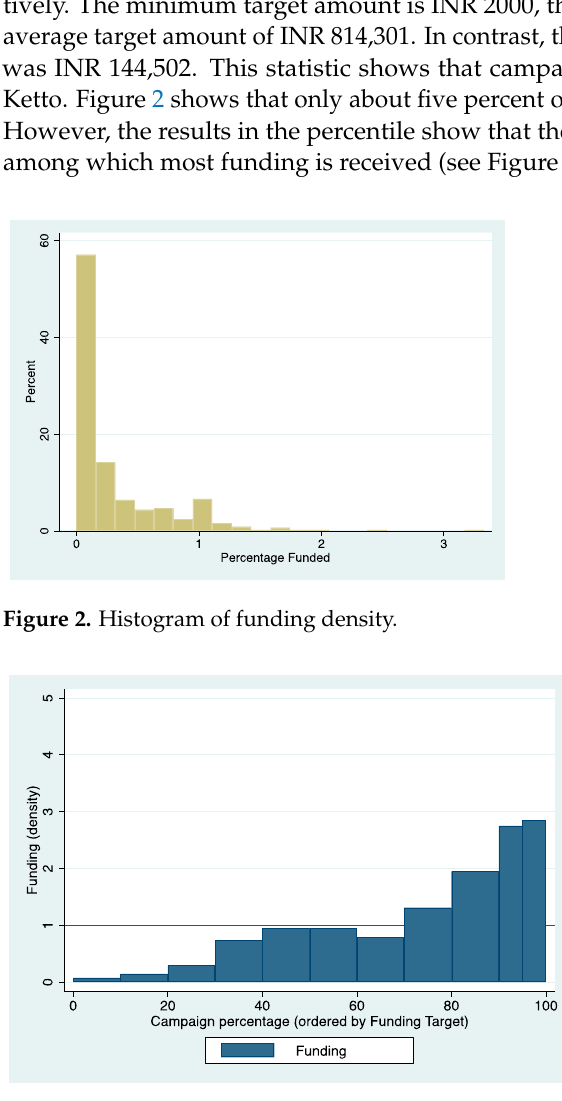
Figure 3. Funding amount received ordered by funding target.